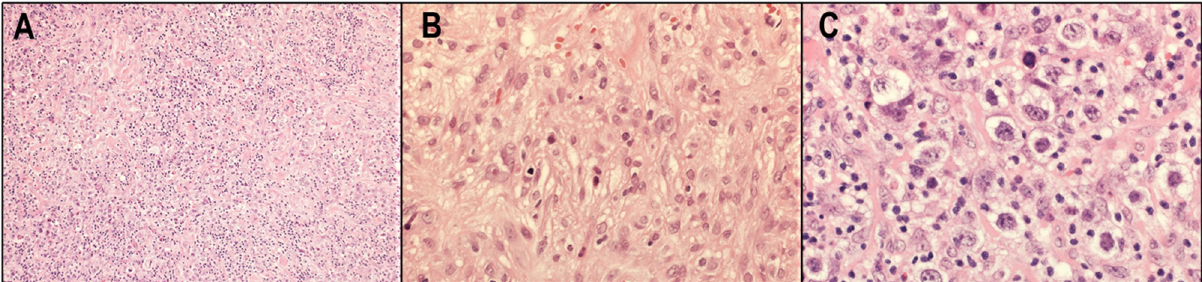
Figure 5. Lymphocyte-depleted classic Hodgkin lymphoma (LDCHL). ( A ) LDCHLs have relatively abundant neoplastic cells and diminished background cells (HE × 40). ( B ) LDCHLs with diffuse fibrosis (HE × 400). ( C ) LDCHLs with rich neoplastic cells showing a pleomorphic appearance (HE × 400).